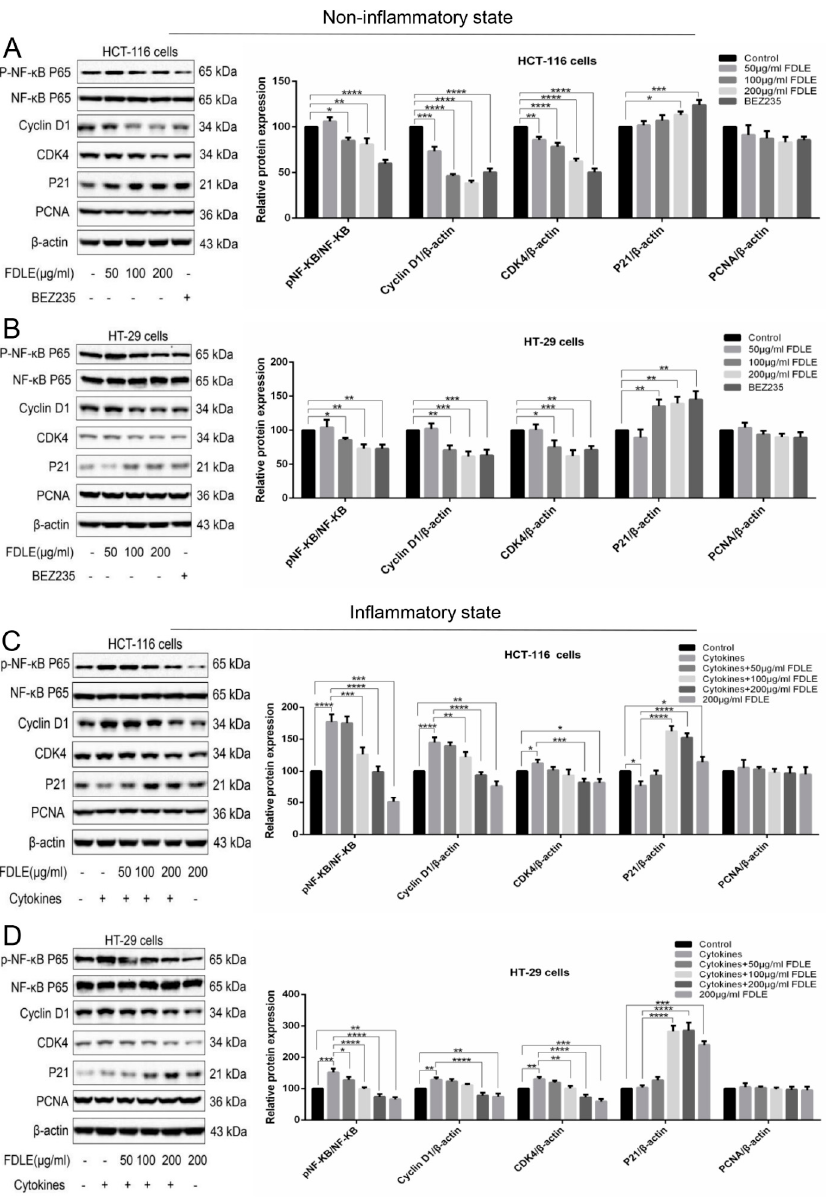
Figure 5. The effects of FDLE on NF- κ B-mediated cell cycle proteins in non-inflammatory and in- flammatory HCT-116 and HT-29 colorectal cancer cell line. ( A , B ) Western blot analysis of NF- κ B-